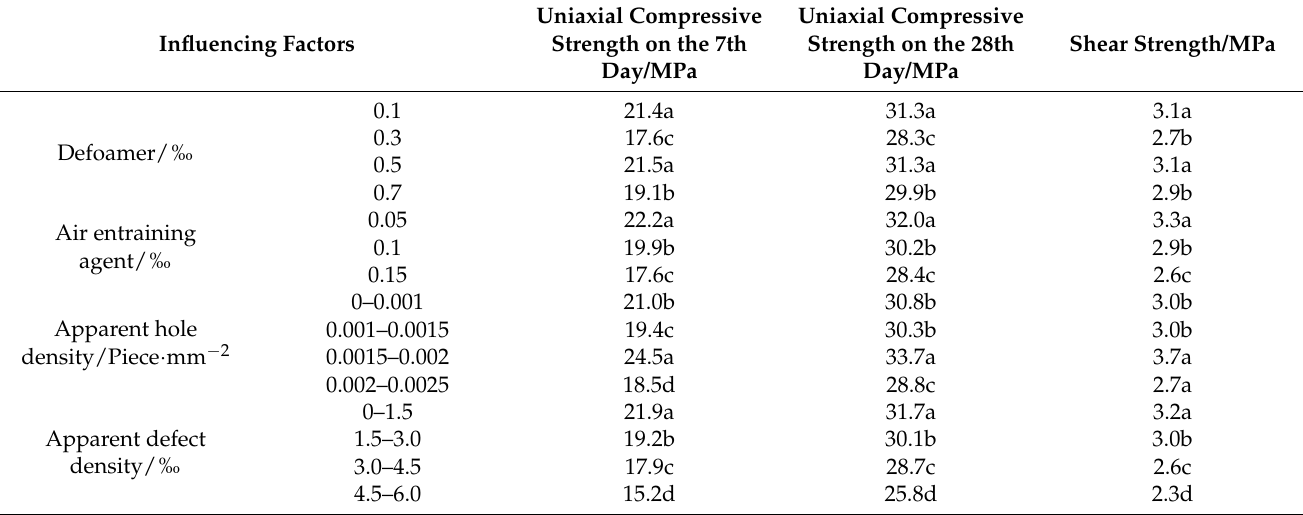
Table 5. Effects of different influencing factors on SCFFC